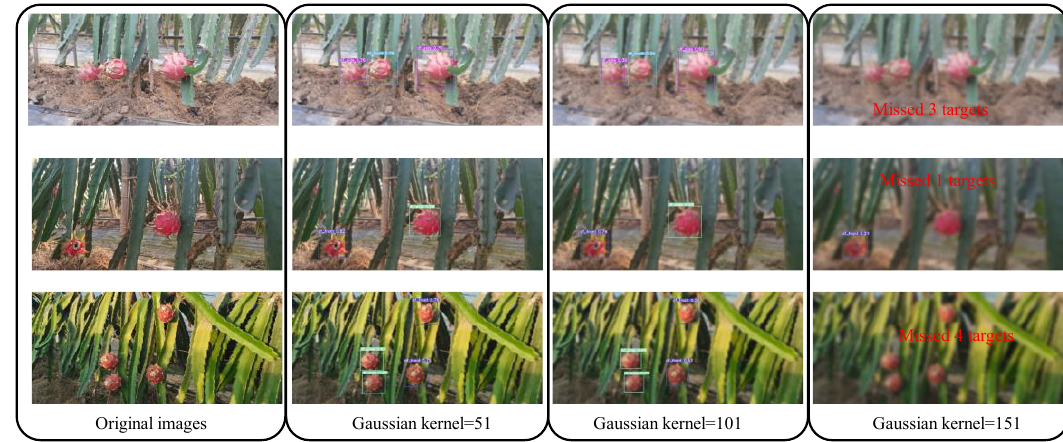
Figure 9. The detection results of images with different Gaussian kernels.